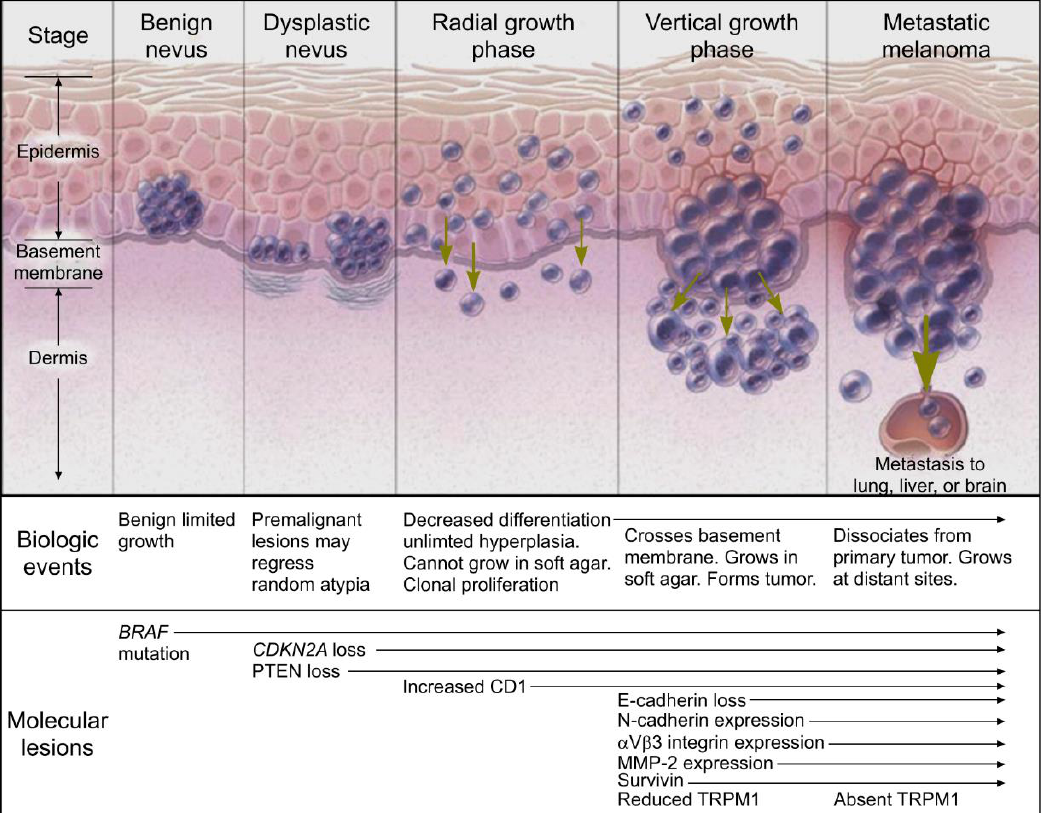
Figure 4. Melanoma progression diagram (reproduced with permission from the New England Journal of Medicine, Arlo J. Miller & Martin C. Mihm, “Melanoma,” 355: 51–65, Copyright © 2020 Massachusetts Medical Society (Waltham, MA). Reprinted with permission from Massachusetts Medical Society, [32] ). Benign nevi have been known to express BRAF mutations that allows for benign and limited growth. This mutation results in the activation of mitogen-activated protein pathway. In the evolution to a dysplastic nevus, cytologic atypia becomes more prevalent through the loss of cyclin dependent kinase inhibitor 2A ( CDKN2A ) and phosphatase and tensin homologue (PTEN), resulting in what is often referred to as a premalignant lesion. The radial growth phase shows clonal proliferation and decreased differentiation accompanied by decreased expression of MITF (micropthalmia-associated transcription factor). The formation of a tumor characterizes the vertical growth phase with the crossing of the basement membrane. An absence of TRPM1 (melanocyte-specific gene melastitin 1) correlates with metastatic capability, but the function of the gene is unknown. There are several other genes involved in the melanoma including loss of E-cadherin, increased expression of N-cadherin, αVβ3 integrin expression, and survivin.